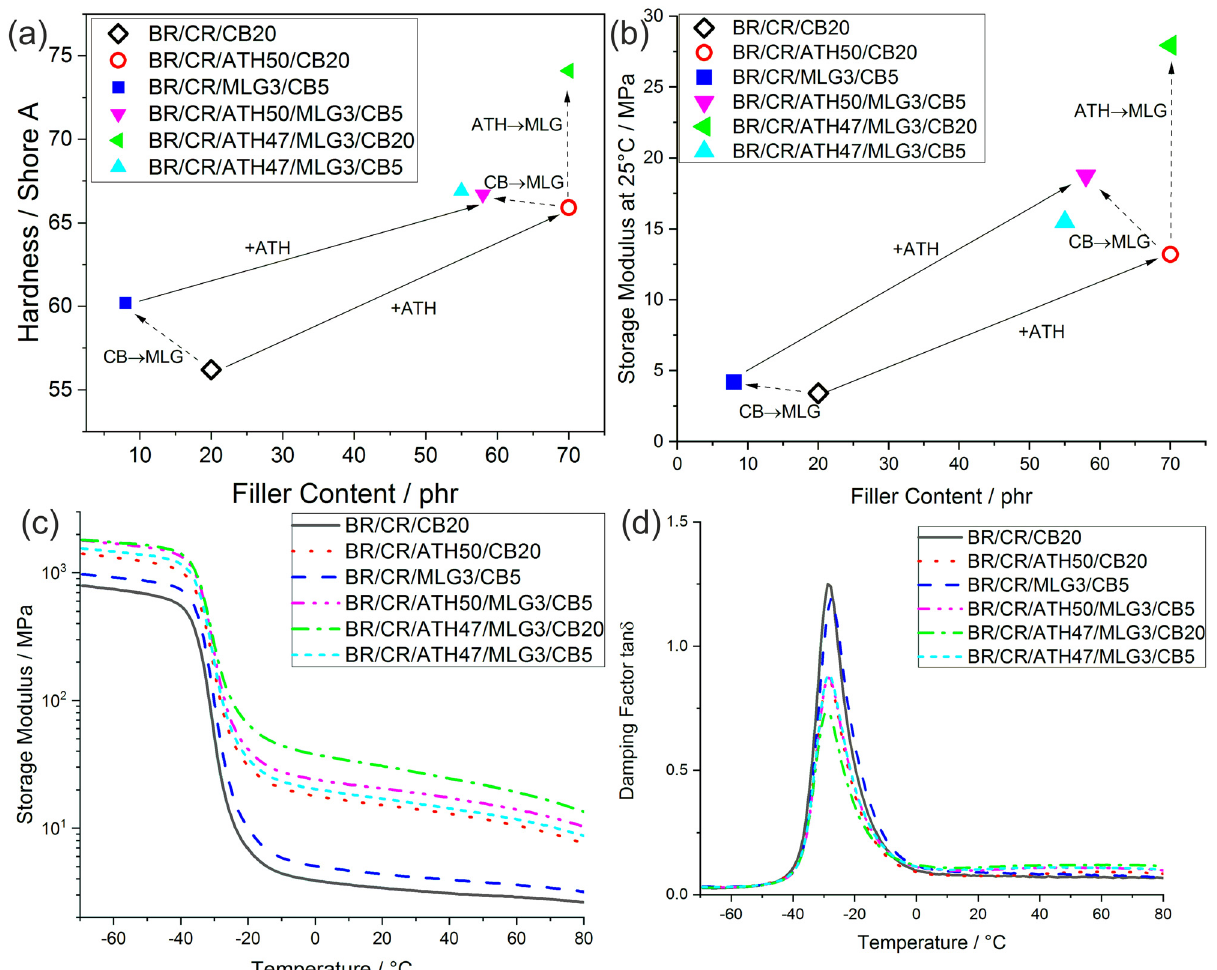
Figure 8: Hardness and dynamic mechanical results of BR/CR nanocomposites; ( a ) hardness in Shore A, ( b ) storage modulus ( G ′ ) and ( c ) damping factor ( tan δ ) as a function of temperature, and ( d ) storage modulus at 25°C as a function of fi ller content. Solid line is addition of 50 phr ATH; dashed line is replacement of 15 phr CB with 3 phr MLG, or 3 phr ATH with 3 phr MLG, respectively.